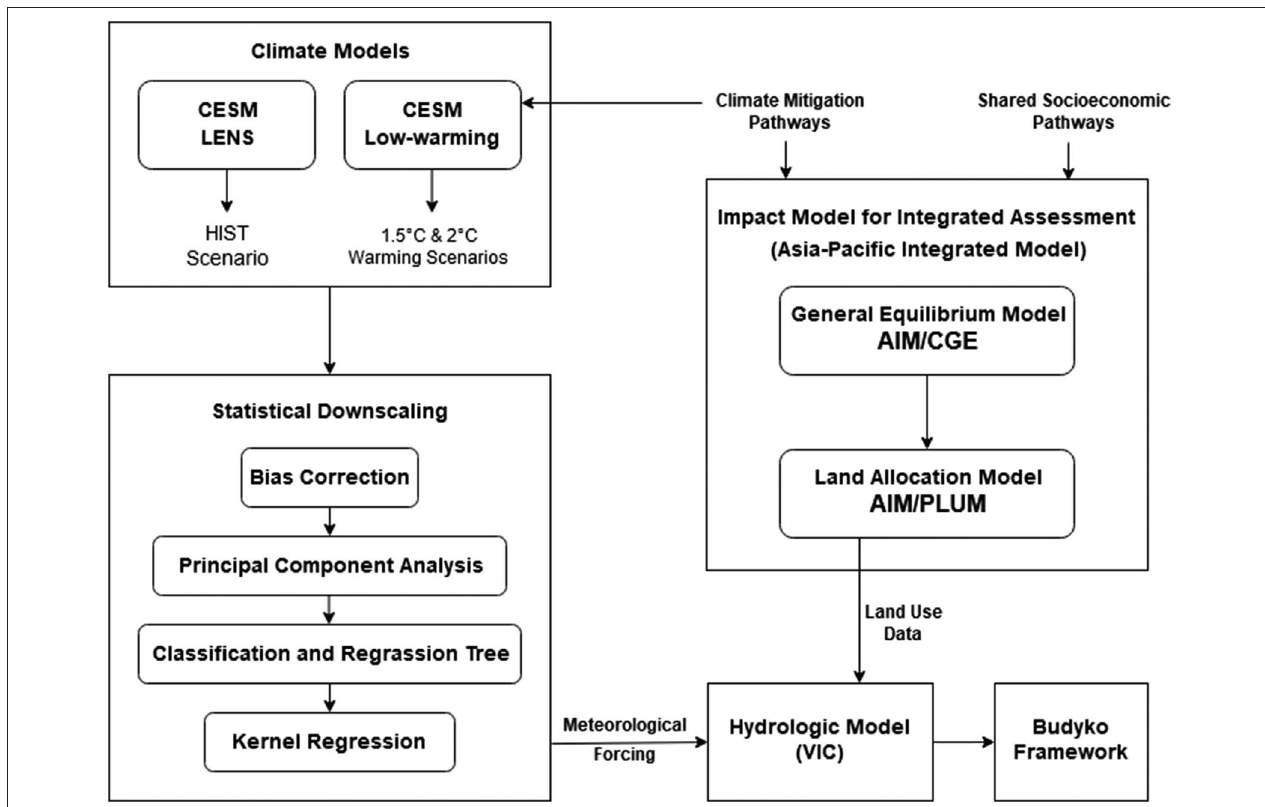
FIGURE 1 | Methodological framework of the